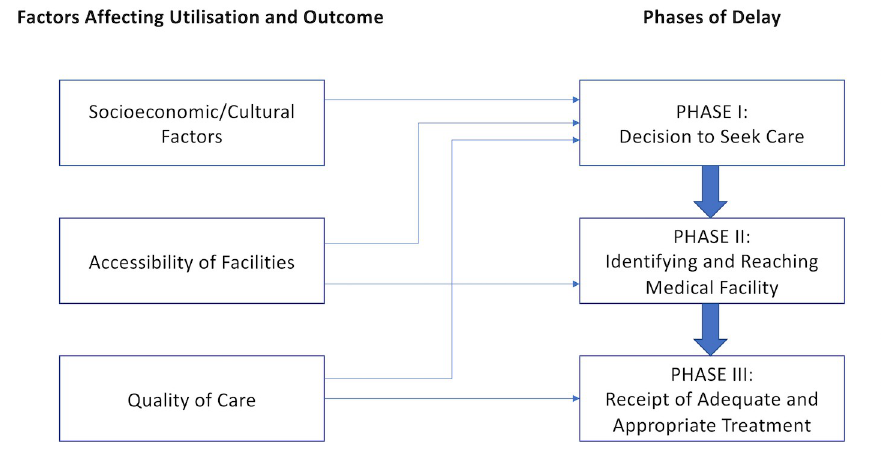
Fig 1. The Three Delays Model: Thaddeus and Maine